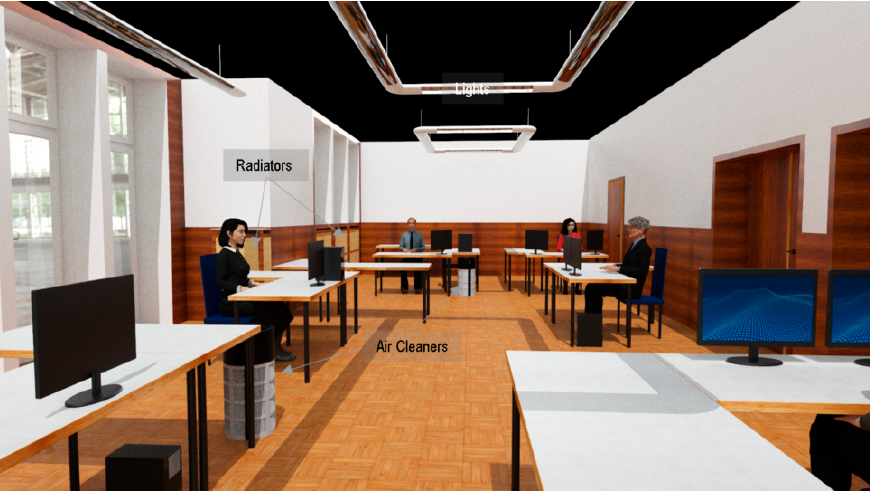
Figure 2. Simulated geometry of the office room.